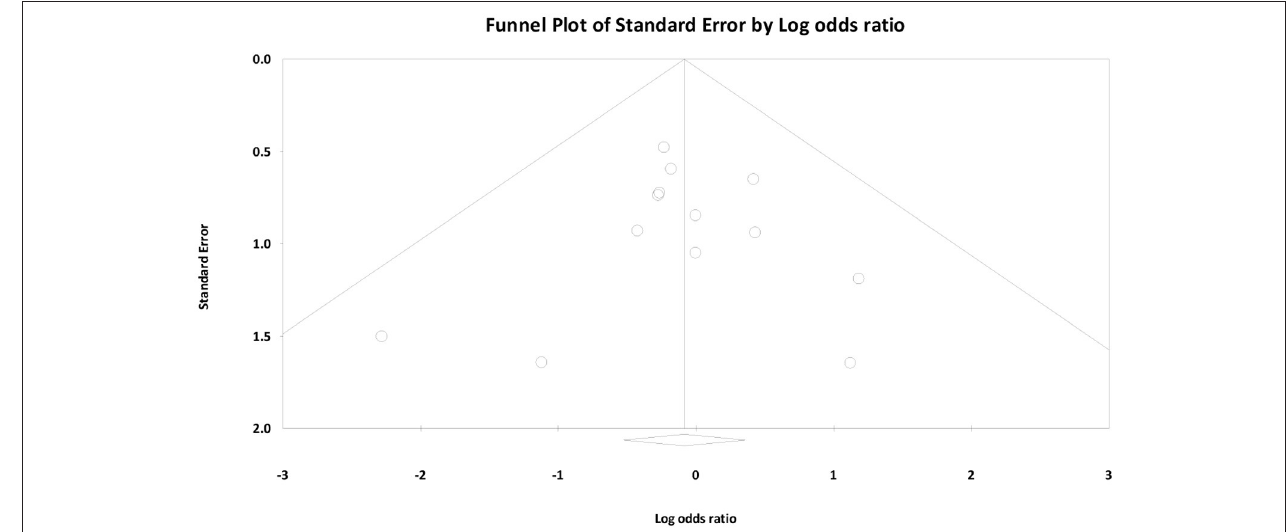
FIGURE 7 | Funnel plots to explore the possibility of publication